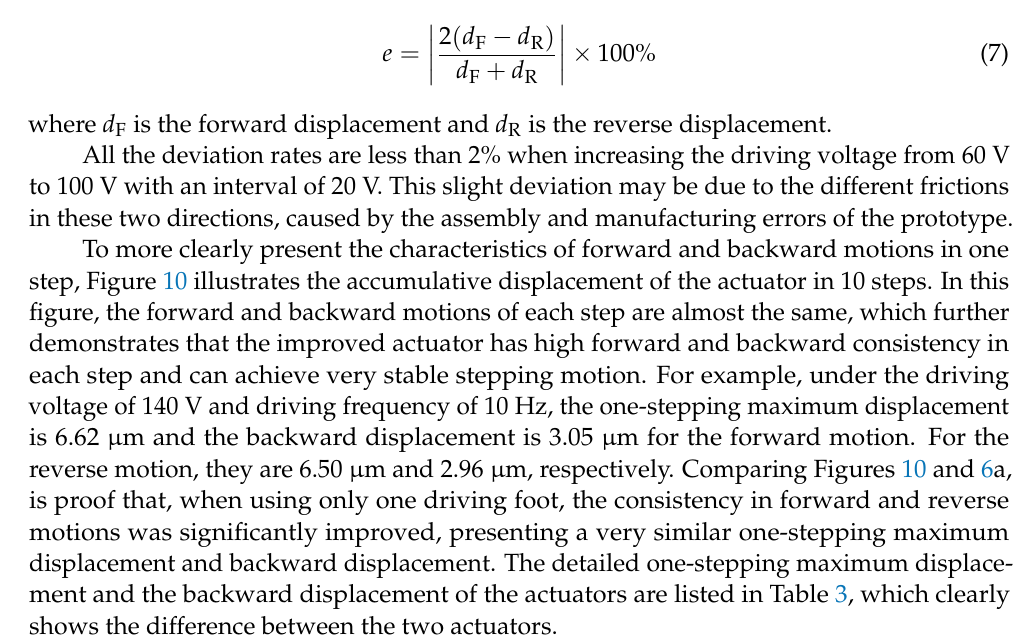
Figure 9. ( a ) The forward and reverse cumulative displacements of the improved actuator in 40 steps obtained under the fixed driving frequency of 10 Hz and various driving voltages, and ( b ) the corresponding speed changing with the driving voltage. Table 2. The detailed forward and reverse displacements of 40 steps obtained under various driving voltages, as well as the deviation analysis.